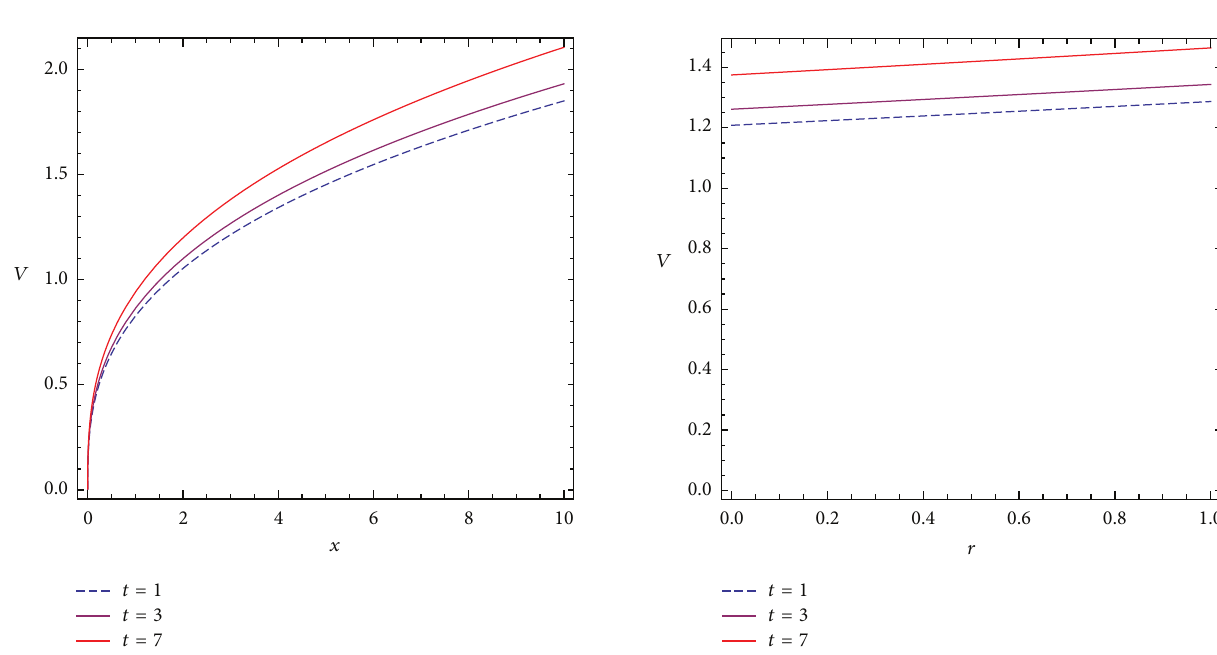
Figure 1: The optimal value function varies with respect to 𝑥 . Figure 2: The optimal value function varies with respect to 𝑟 .